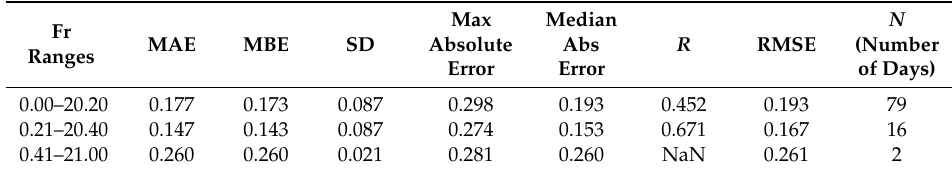
Table 4. Summary of EF comparisons with Fractional Vegetation Cover (Fr) for all the experimental sites and all the studied parameters.